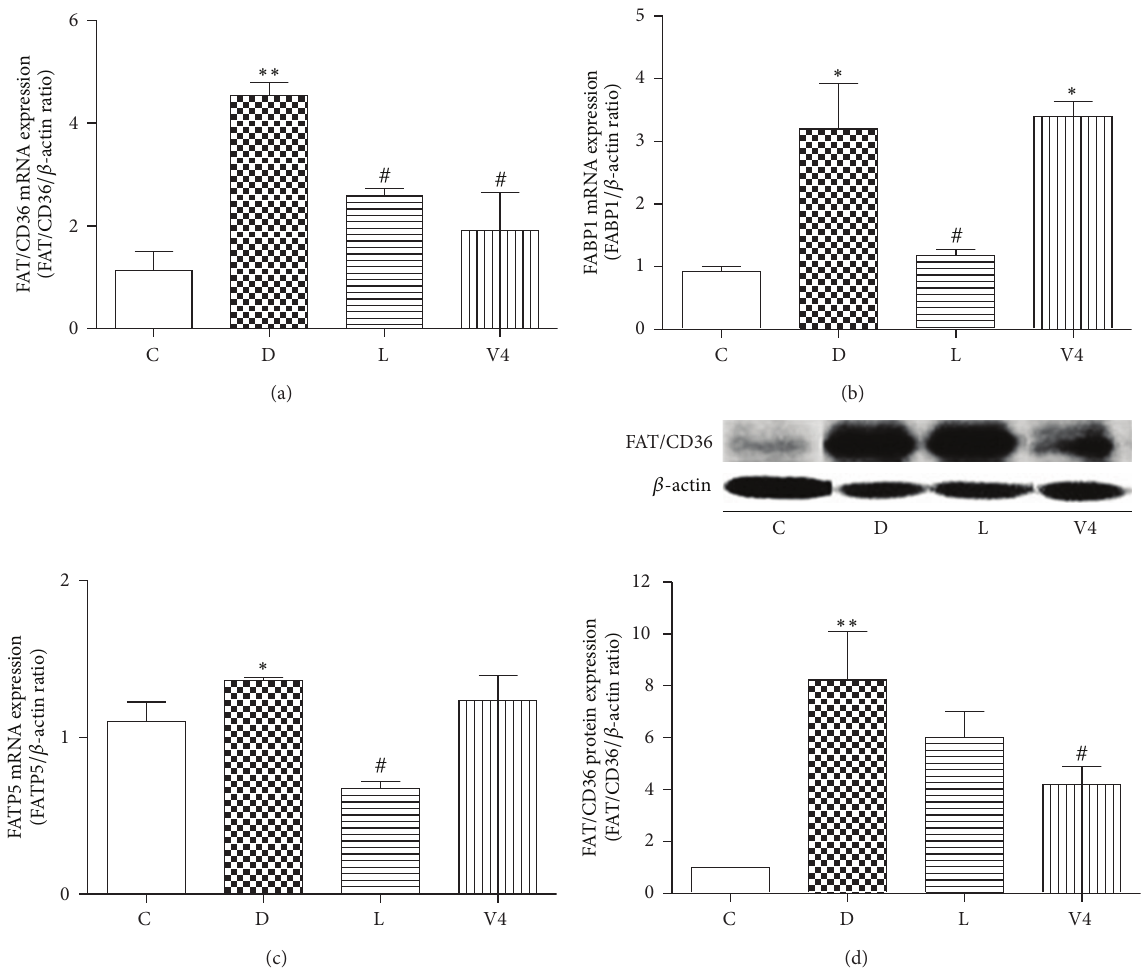
Figure 4: Effects of V 4 dipic-Cl on mRNA expression levels of FAT/CD36, FABP1, and FATP5 and protein level of FAT/CD36 in STZ- induced diabetic rats. C: Control group, D: Diabetic group, L: H 2 dipic-Cl-treated group, V4: V 4 dipic-Cl-treated group. Values are expressed as mean ± SEM, 𝑛 = 3 . ∗ 𝑃 < 0.05 , ∗∗ 𝑃 < 0.01 versus C. # 𝑃 < 0.05 , versus